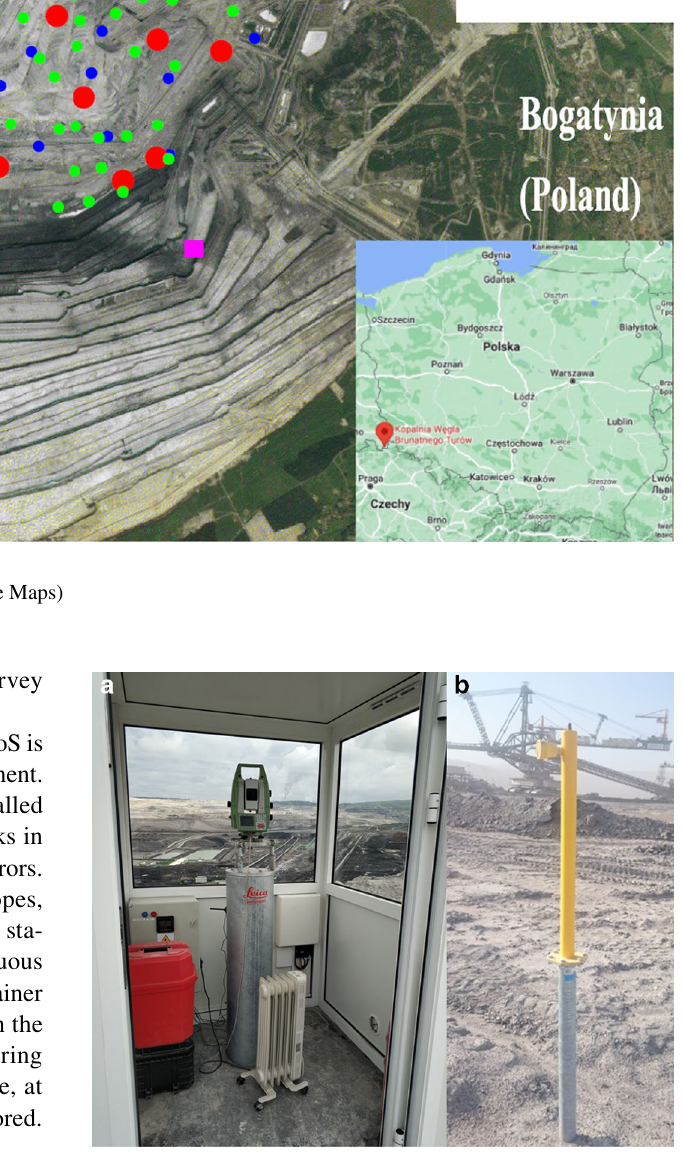
Fig. 3 a Inside the measuring container; b GeoMoS control